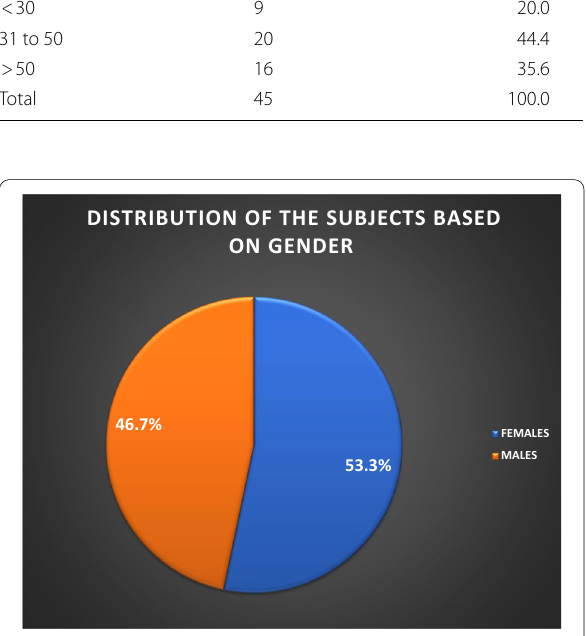
Fig. 2 Gender-wise distribution of subjects